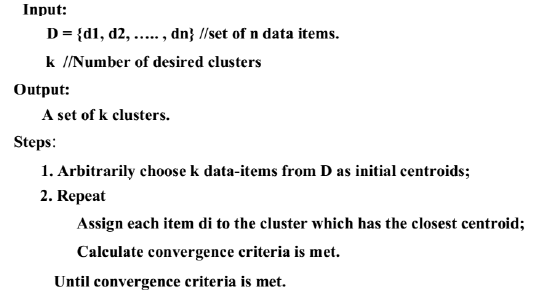
Figure 2: Pseudocode of K-means algorithm for clustering population